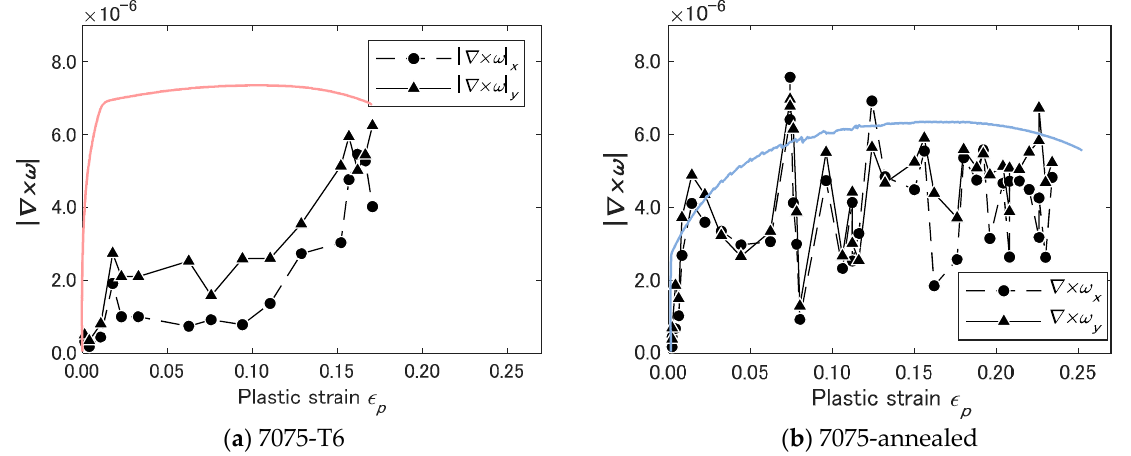
ω∇× |∇ × ω | (average over shear band zone) during the tensile (average over shear band zone) during the tensile test. Figure 11. Variation of